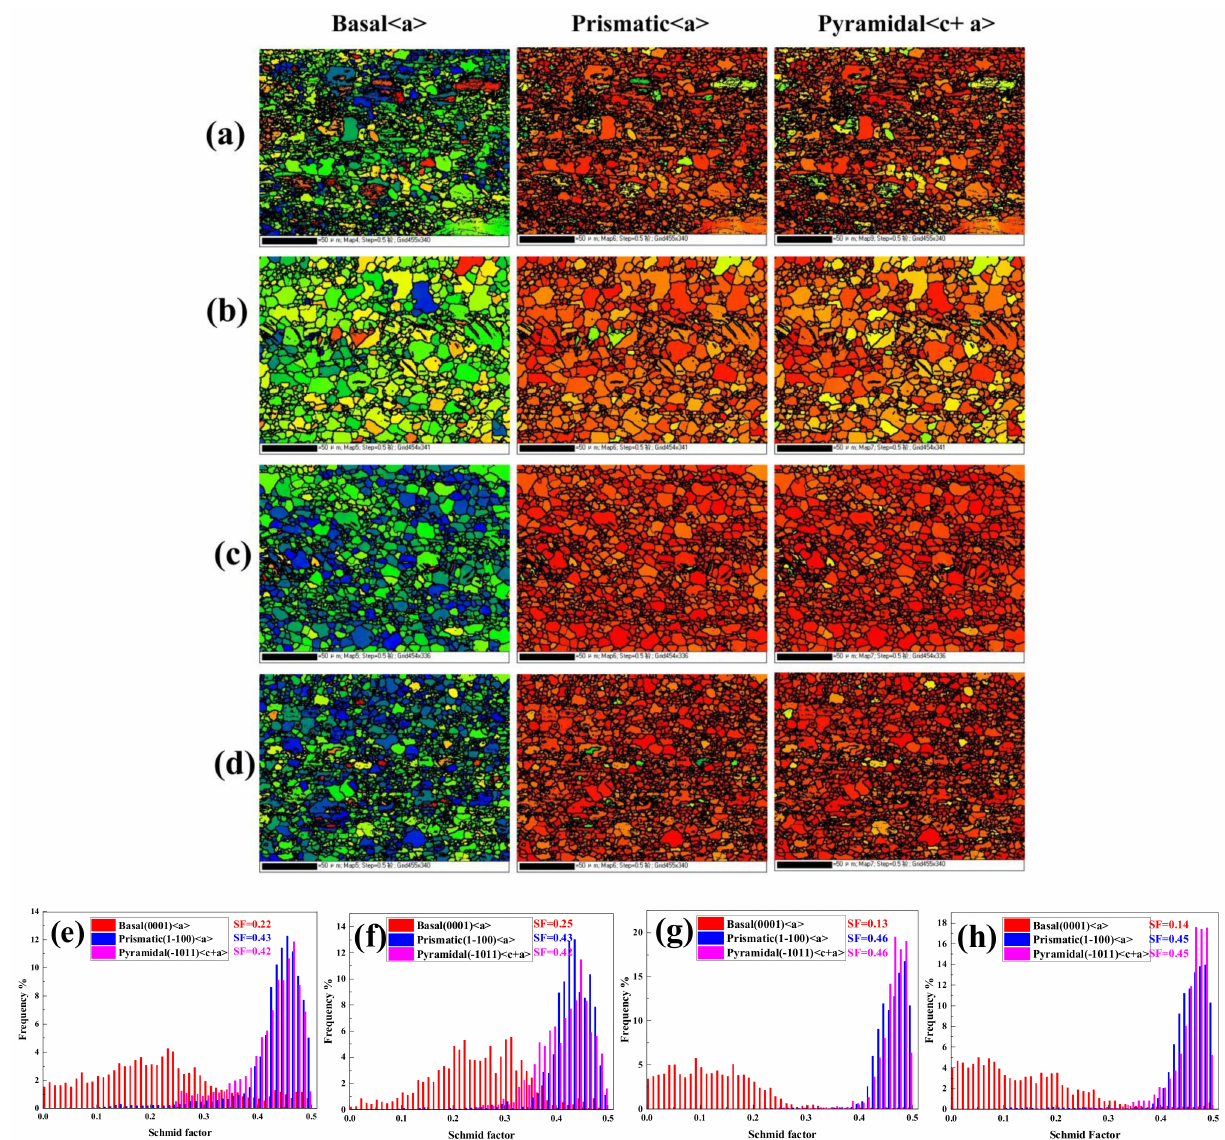
Figure 8. Schmid factors maps and distribution for (0001)/<11-20> basal slip, (10-10)/<11-20> prismatic slip, (10-11)/<11-23> pyramidal slip of as-extrudedTX31 ( a , e ); TXZ311 ( b , f ); TXC311 ( c , g );TXCZ3111 ( d , h ) alloy,